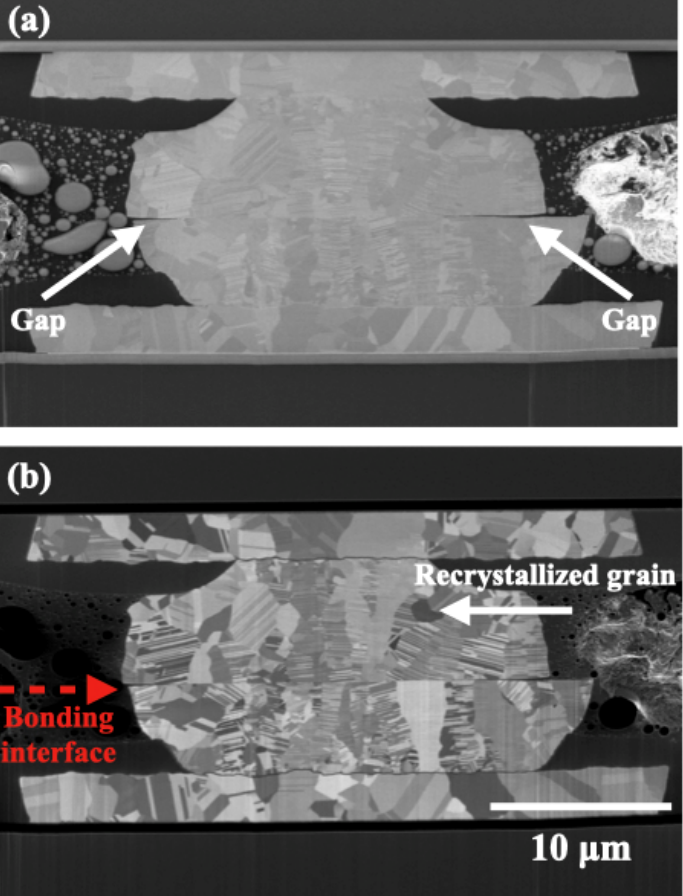
Figure 7. ( a ) Cross-sectional FIB electron and ( b ) ion images of the microbumps bonded under 47 MPa/10 s at 300 °C.